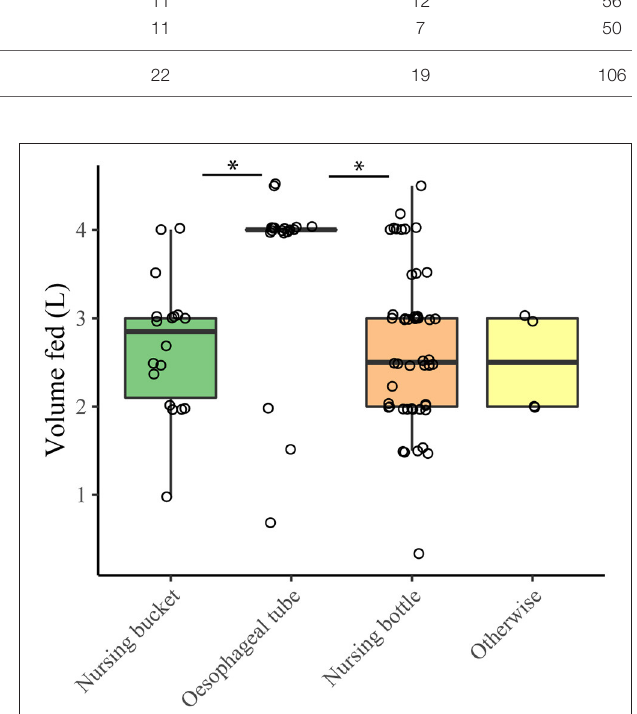
FIGURE 2 | Volume of colostrum fed with the first colostrum feeding with different feeding methods ( n = 89). * p < 0.05 (Wilcoxon rank sum test). The amount of colostrum fed with an esophageal tube was reported to be 4 liters 13 out of 18 times, resulting in the quartiles, minimum and maximum of the boxplot coinciding with the